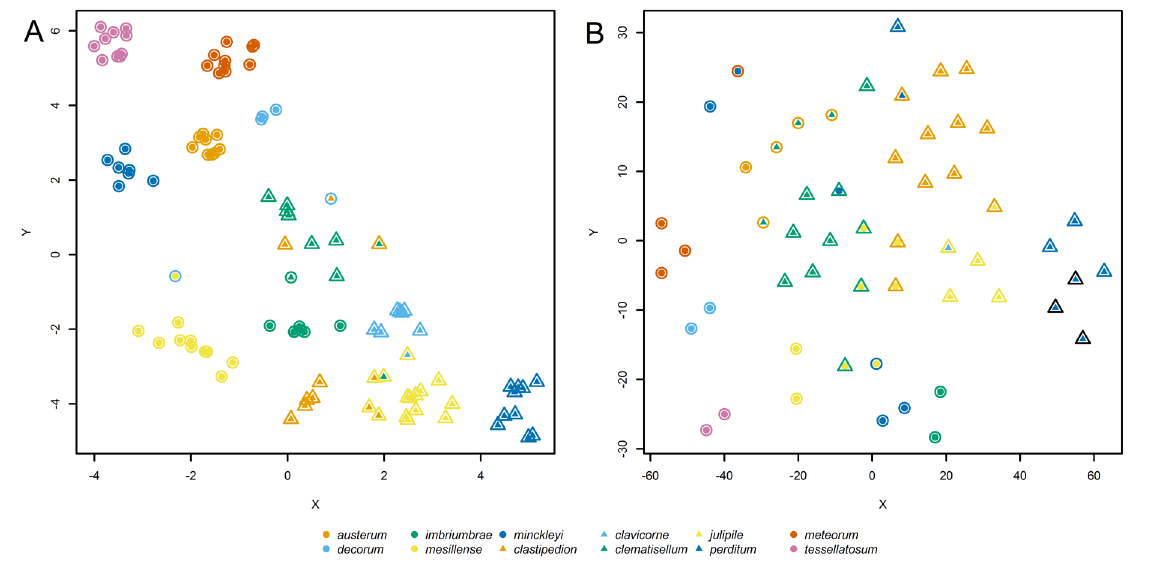
Fig. 6. Two-dimensional representation of clusters created by PAM. A . ♀♀. B . ♂♂. Actual species identifications are indicated by the colour of filled centre points, and cluster assignments by PAM are indicated by borders around each point. Black borders in B indicate a second cluster corresponding to L. ( D. ) perditum sp.